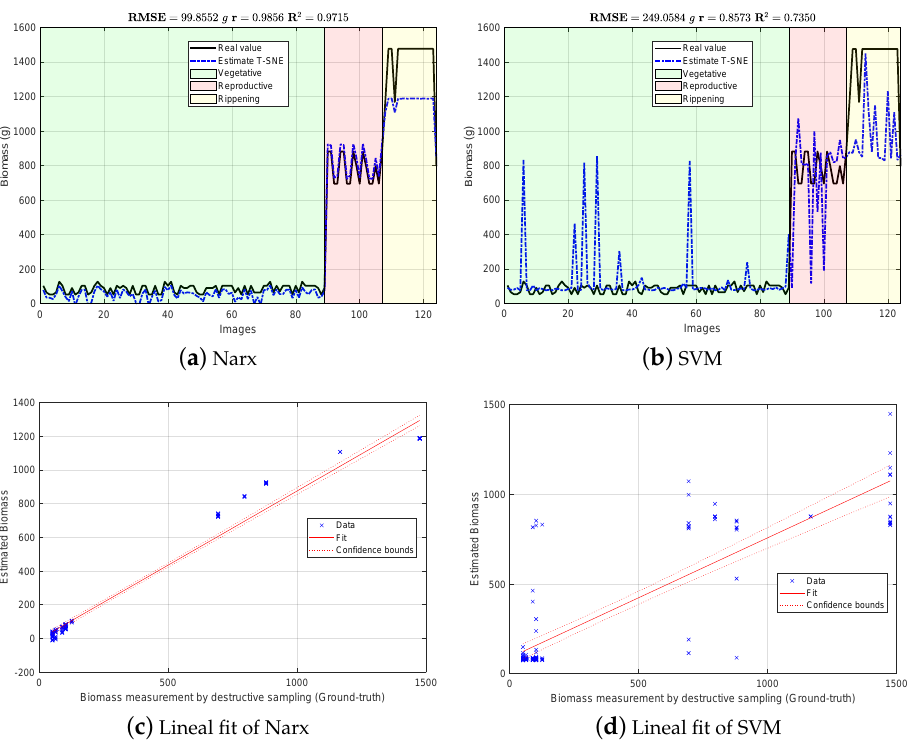
Figure 5. Biomass estimations using the graph-based approach with uniform sampling features (GBF).